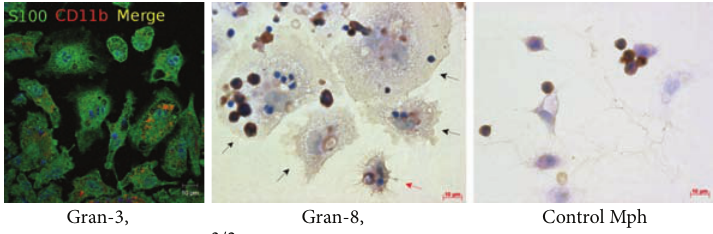
Figure 14: The S100 proteins in the cells in the fragments of mouse splenic granulomas and control mouse peritoneal macrophages (Mph). The scale bars are 10 𝜇 m each. In the left panel, confocal immunofluorescent localization of S100 proteins (green signal) and CD11b (red signal). Colocalization of the markers on confocal images of cells (yellow signal). Nuclei are stained by DAPI (blue signal). In the central and right panels, immunochemical localization of S100 proteins in the cells. The brown color indicates the presence of the markers in these cells. The black and red arrows indicate macrophages and a dendritic cell, respectively, with increased production of S100 proteins. Abbreviations as in Figure